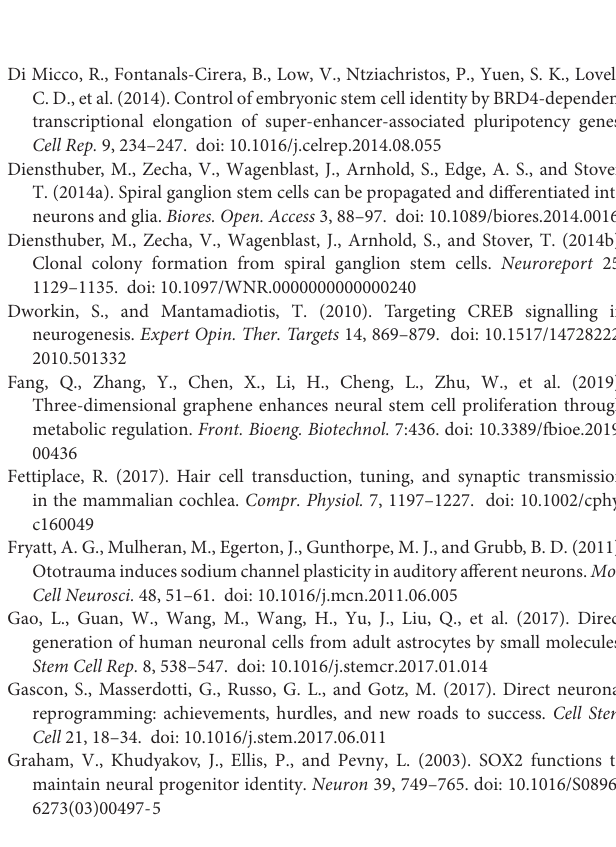
Supplementary Figure 2 | Small molecules screening and optimization. (A) Representative images of TUJ1 immunostaining of iNs treated with various concentrations of small molecules, I-BET, Forskolin, ISX9, Chir99021 at 15 div. (B) Representative images of Prox1 immunostaining of iNs treated with small molecules Y27632, SB431542, RA, LIF, Vitamin C, and VPA at 15 div. The white arrowheads represent Prox1 + cells. Supplementary Figure 3 | Specific expression of SGN markers. (A) Representative cartoon showing cochlear localization of SGNs and surrounding glial cells. (B–G) Specific expressions of TUJ1 (B) , Gata3 (C) , Syp (D) , Prox1 (E) , Map2 (F) , and Scrt2 (G) in P3–P42 cochlear SGNs. Supplementary Figure 4 | RT-qPCR validations of glial and neuronal genes regulated during FIBCL-induced differentiation. mRNA expressions of Islet1 , Scrt2 , Pou4f1 , Prox1 , Sox10 , Sox2 , Ntrk3 , and S100a4 (as highlighted in Figure 8H ) in non-differentiated spheres or differentiated cultures treated with SCDM, SCDM/FGF, or FIBCL were analyzed by RT-qPCR. N = 3, error bars represent mean ± SD. * p < 0.05, ** p < 0.01, *** p < 0.001 by one-way